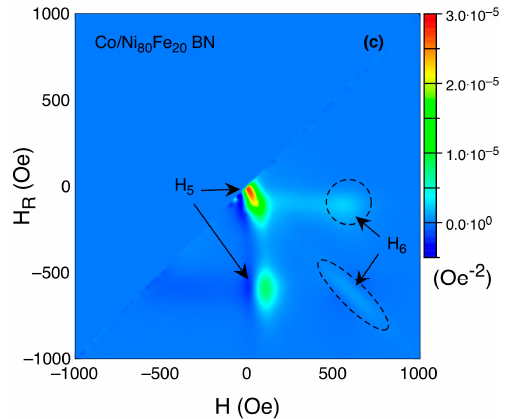
Figure 4. (Colour online) First order reversal curves (FORC) of Ni 80 Fe 20 antidot arrays ( a ); Co dot arrays ( b ) and bi-component nanostructured systems ( c ). The colour plots represent the distribution of the second derivative of the normalised magnetisation with respect to the applied field, H, and the reversal field H R (in Oe − 2 ). Values of the distribution close to zero correspond to reversible magnetisation processes, whereas the values of the distributions different than zero correspond to irreversible magnetisation processes. Regions highlighted with dashed lines better put in evidence the features marked with H 3 and H 6 .